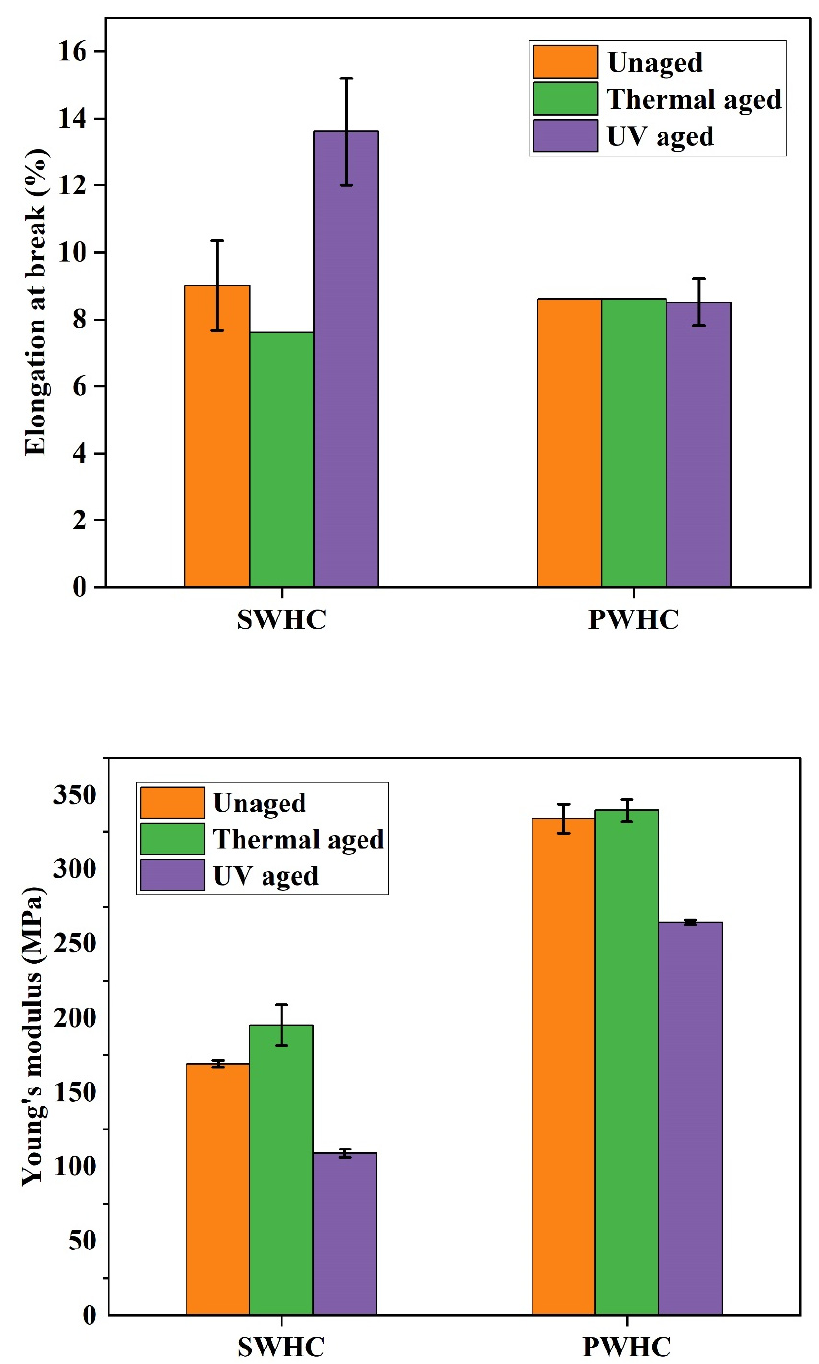
Figure 8. Mechanical properties of the SWHC and PWHC after the thermal and UV aging.